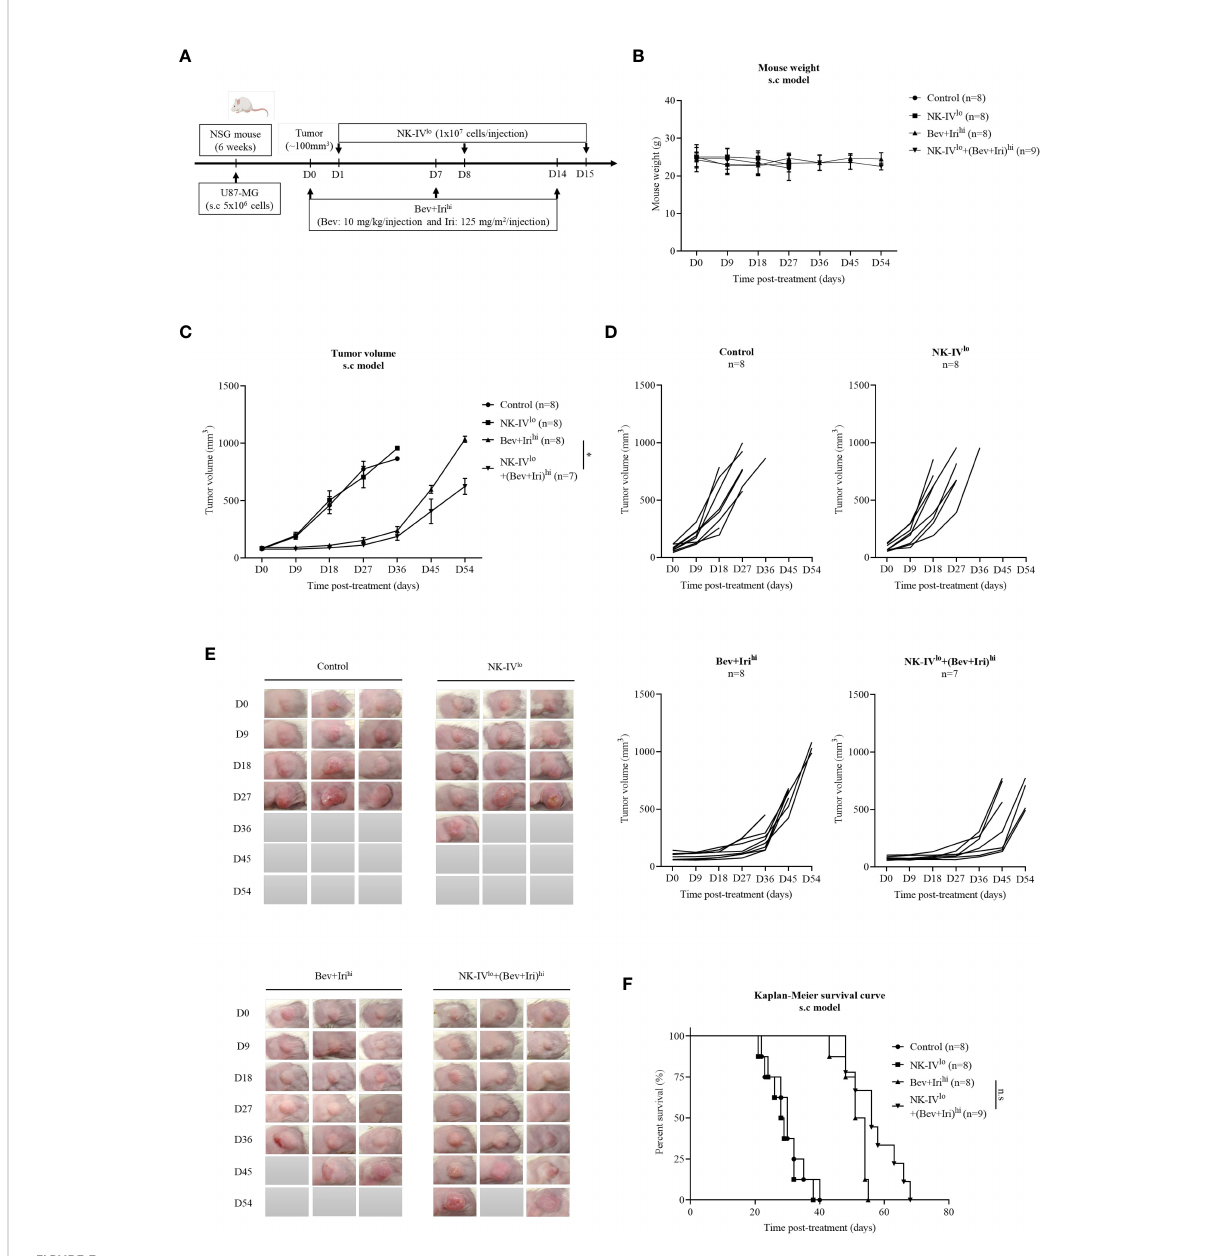
FIGURE 3 Experimental treatment schedules and therapeutic effects of NK-HD cells in combination with Bev plus Iri estimated in the s.c U87 mouse model. At a tumor size of 100 mm 3 , the mice were treated with Bev and Iri every 7 days for 14 days. NK-HD cells were injected after 1 day of Bev and Iri treatment (A) . The mouse weight before and after the treatment with NK-HD cells in combination with Bev and Iri was clari fi ed every 9 days (B) . The tumor size before and after the treatment with NK-HD cells in combination with Bev and Iri was clari fi ed every 9 days and the tumor volume was calculated as follows: V = 4/3 p (length × width × height/8) (C – E) . The Kaplan – Meier survival of U87-bearing mice of control, NK-IV lo , Bev plus Iri hi , and NK-IV lo in combination with Bev plus Iri hi group was estimated. The statistical signi fi cance of survival was determined using a log-rank test with